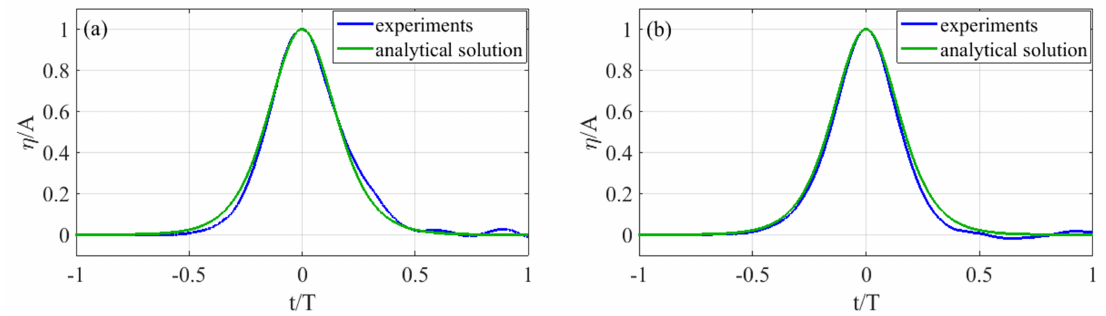
Figure 3. Time variation of surface elevation, η , in correspondence to the vertical axis of the cylinder: comparison between analytical solution and experiments. ( a ) Test number 5; ( b ) Test number 30.